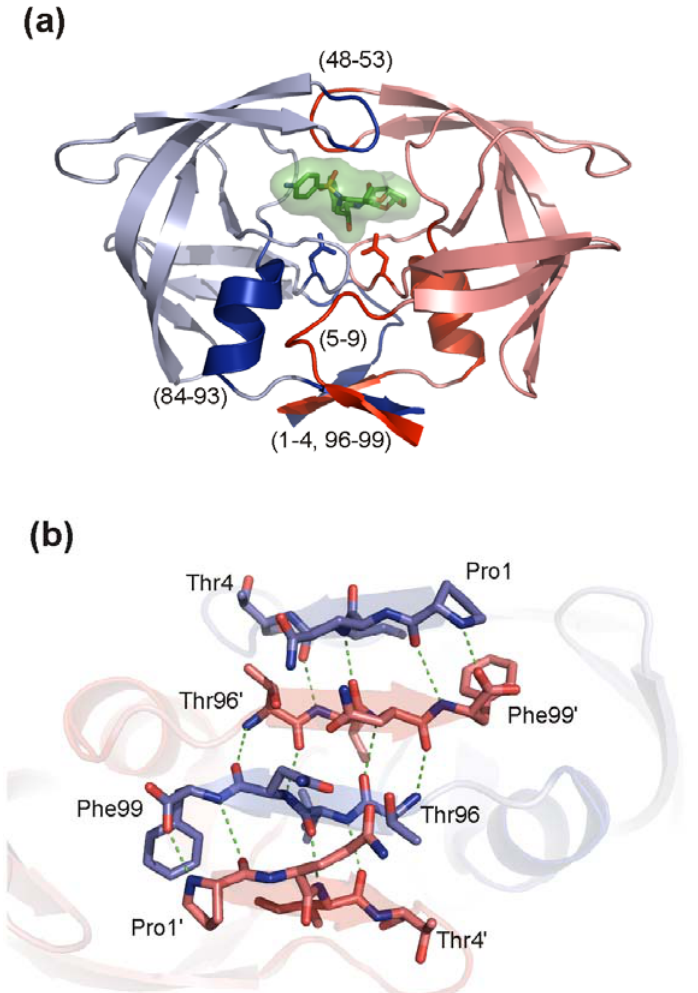
Figure 8. HIV PR dimerization interface. (a) The overall structure of the HIV PR dimer with an inhibitor bound in the active site. Monomers are colored blue and red, respectively. Regions involved in creation of a dimeric interface are highlighted by darker shades and indicated by residue numbers. (b) A detail of the four-stranded antiparallel β -sheet formed by interdigitation of C- and N-terminal strands. Monomers are colored blue and red, respectively. A hydrogen bonding network is represented by green dashed lines. The figure was generated using the structure of highly mutated, patient derived HIV-1 PR (PDB code 3GGU [8]) and program PyMol